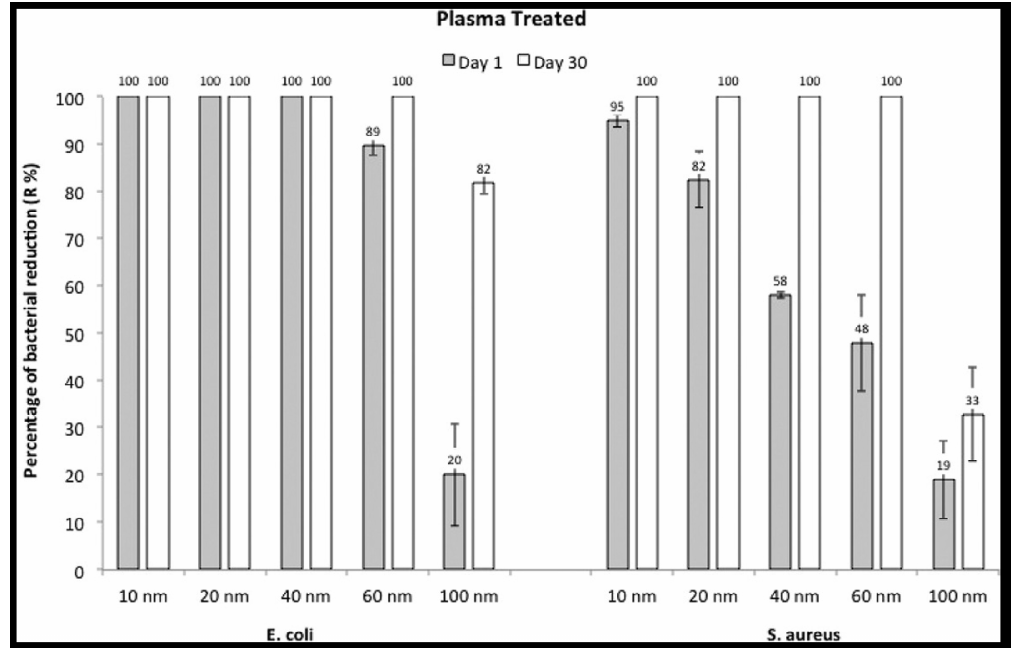
Figure 14. Percentage of bacterial reduction ( E. coli and S. aureus ) as a function of the size of AgNPs after exposure of 1 day and 30 days. Data are presented as mean values ± SD ( n = 3). Reproduced from [137] with permission of the American Chemical Society.